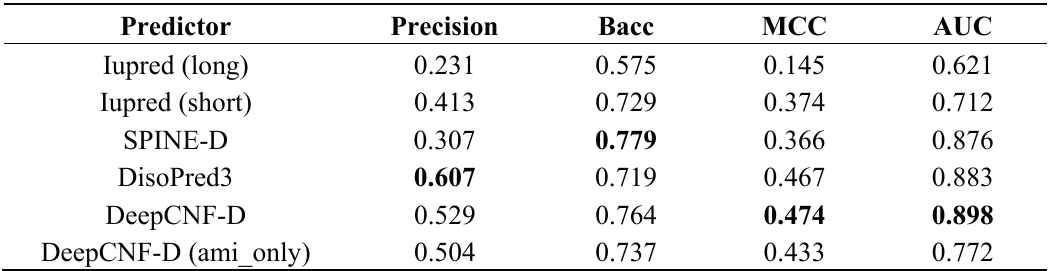
Table 7. Performance of several predictors on CASP10. We show average value for precision, balanced accuracy (bacc), Mattehews correlation coefficient (MCC), and Area under the ROC curve